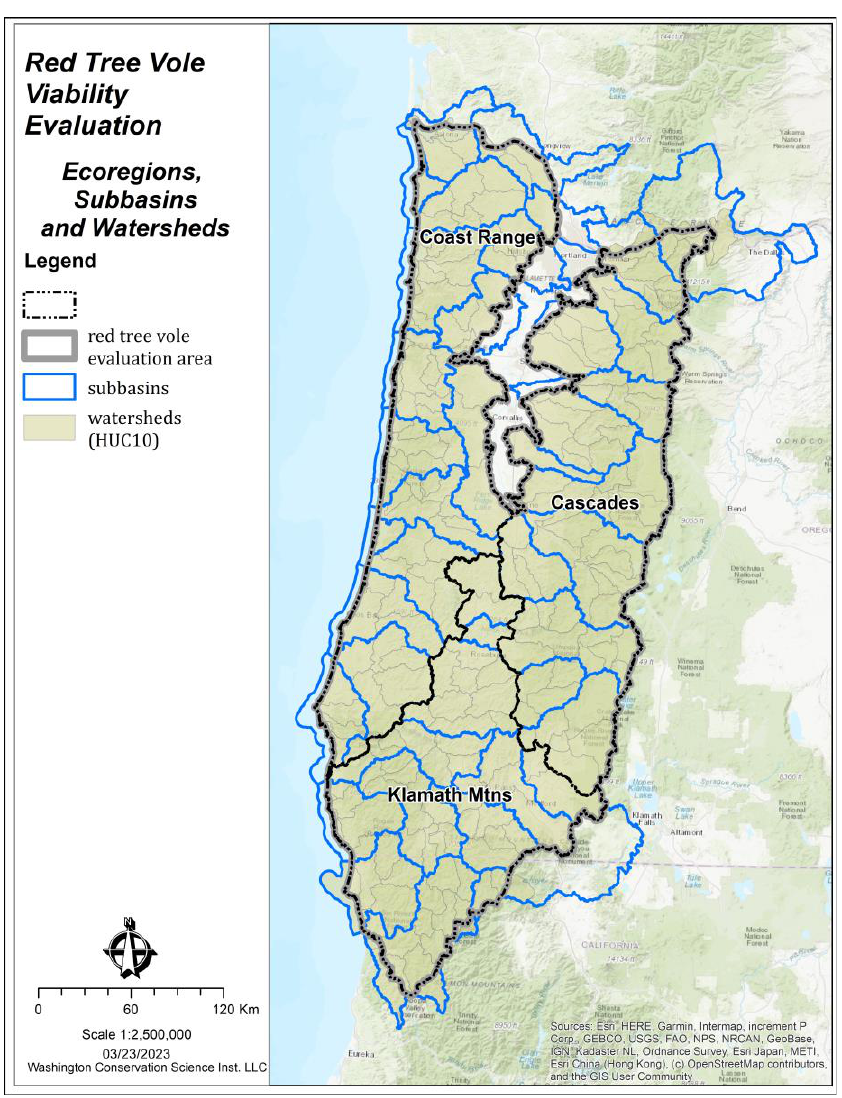
Figure 2. Watersheds, sub-basins, and ecoregions in the red tree vole ( Arborimus longicaudus ) evalu- ation area, Oregon and California, USA.